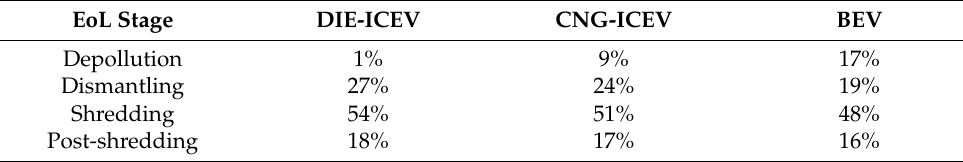
Table 2. Contribution to material removal of each EoL stage in mass